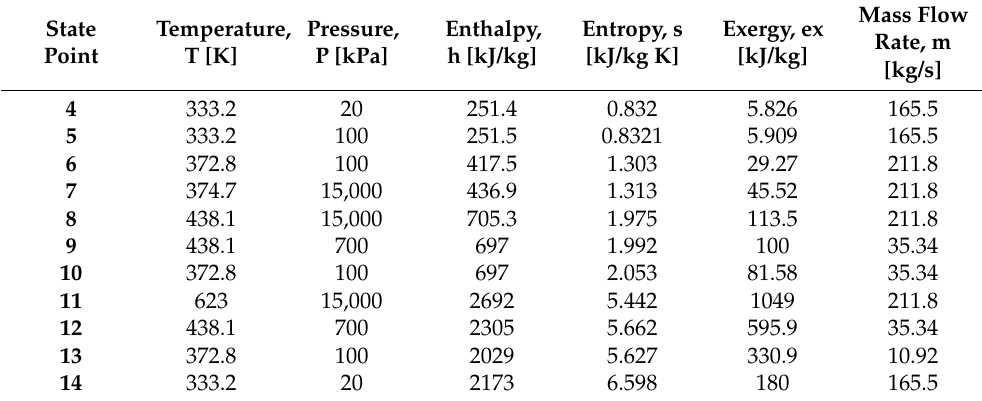
Table 2. State point values of Temperature, Pressure, Enthalpy, Entropy, Exergy and Mass flow rate of Regenerative Rankine Cycle.